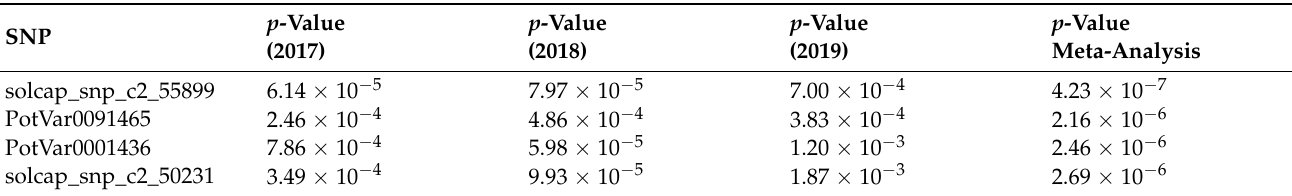
Table 1. p -Values for SNPs with the highest − log 10 ( p ) according to meta-analysis.